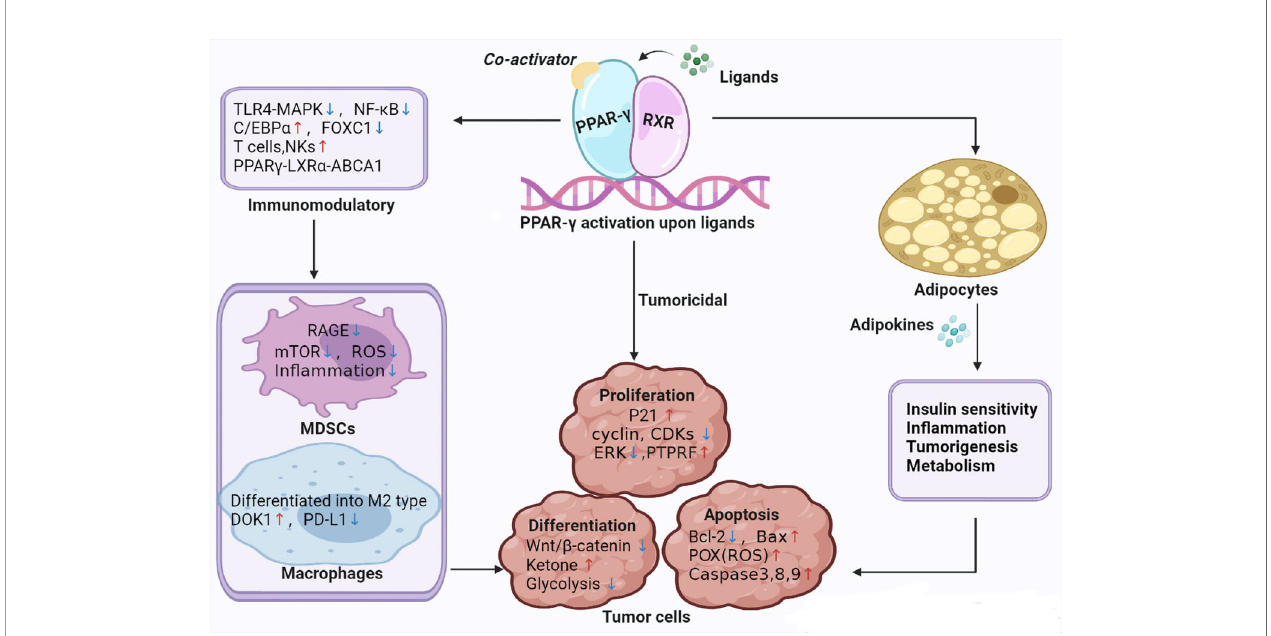
FIGURE 1 | Main mechanisms of PPAR- g in the regulation of tumor. TLR4-MAPK, Toll-like receptor 4-mitogen-activated protein kinases; mTOR, Mechanistic target of rapamycin; C/EBP b , CCAAT/enhancer-binding protein beta; FOXC1, Forkhead box C1; LXR a , liver X receptor alpha; ABCA1, ATP binding cassette A1; NKs, Natural killer; CDKs, Cyclin dependent kinase; PTPRF, protein tyrosine phosphatase receptor type F; ERK, extracellular signal-regulated kinase; POX, Proline Oxidase; DOK1, downstream of tyrosine kinase; PD-L1, programmed death-ligand